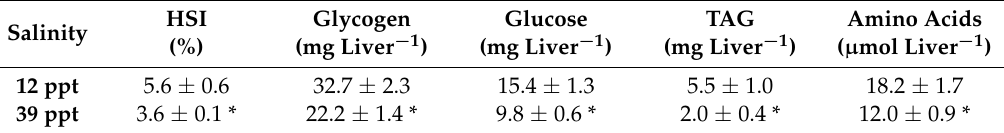
Table 3. Hepatic parameters (hepatosomatic index (HSI) and metabolites) in A. regius fingerlings acclimated to 12 and 39 ppt salinity conditions for 45 days. Data are expressed as the mean ± SEM ( n = 12). Asterisks (*) indicate significant differences among groups ( p < 0.05, Student’s t -test).